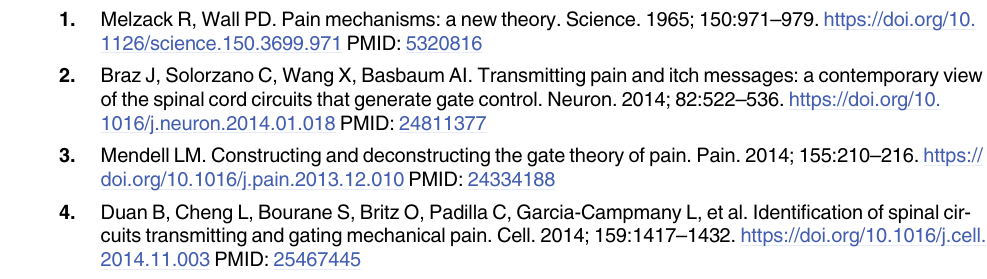
and branch point tracing through a 3D image volume of a DRG. The plugin uses a search algorithm to trace the fluorescently labeled axons between 2 points. The video shows the exam- ple of tracing the stem axon from a peripherin labeled